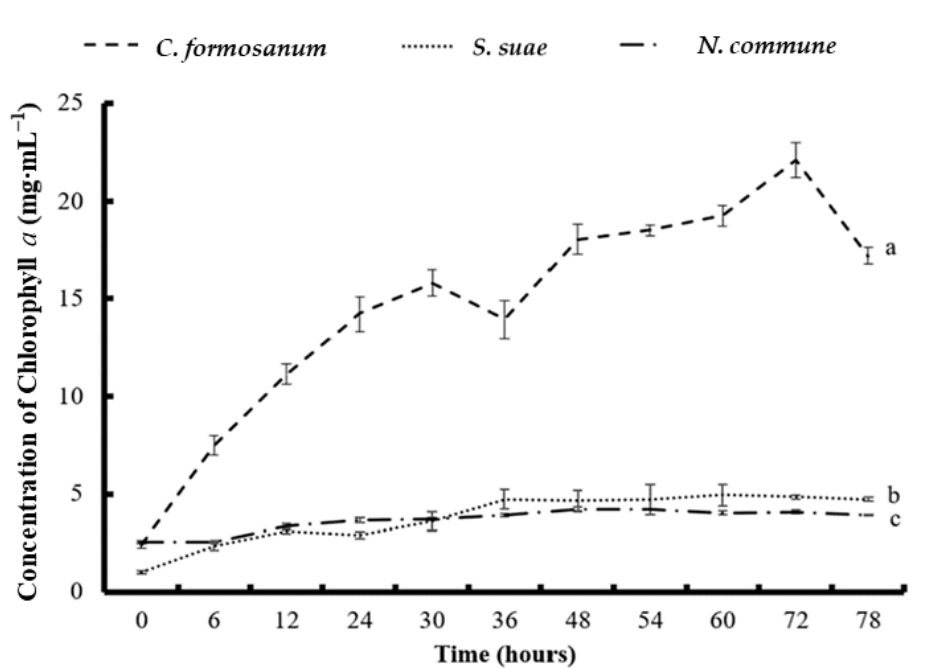
Figure 4. The concentration of chlorophyll a in (a) Colaconema formosanum , (b) Sarcodia suae , and (c) Nostoc commune as substrates fermented with Pseudoalteromonas haloplanktis , ATCC 14393. In the S. suae fermentation experiment, the highest PE and PC concentrations (0.014 APC (0.018 mg mL − 1 ), and Chl a (4.23 mg mL − 1 ) concentrations were all obtained